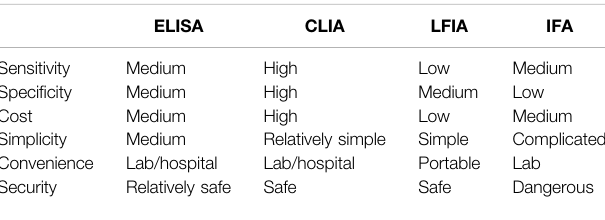
TABLE 2 | Comparison and evaluation of COVID-19 serological diagnosis